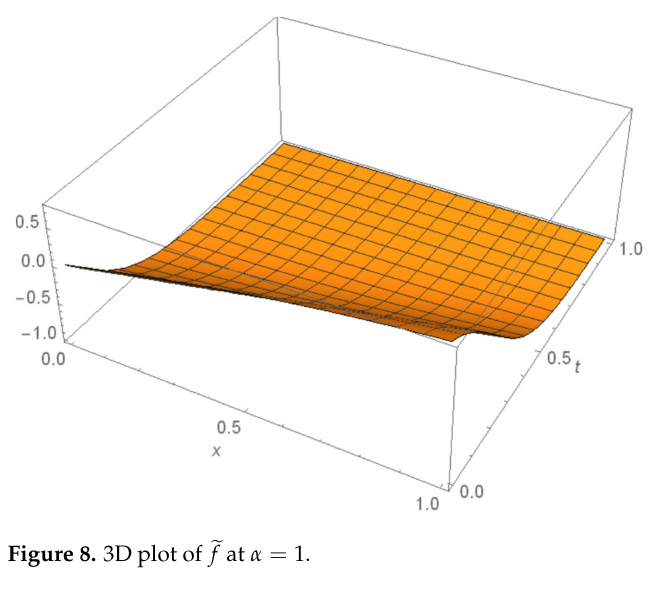
Figure 8. 3D plot of (cid:101) f at α = 1.